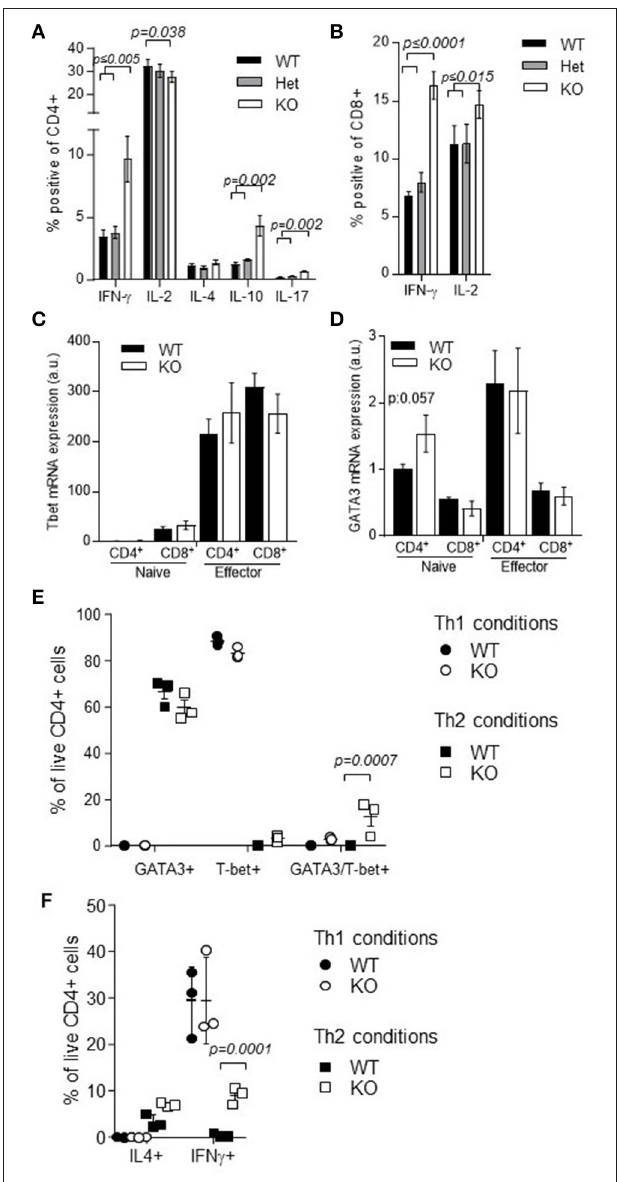
FIGURE 6 | Nup210 KO mice exhibit an inflammatory T cell signature. Splenocytes from wildtype, Nup210 het , Nup210 KO mice ( n = 6, 7, 5) were assessed by flow cytometry. (A) Cytokine production by CD4 + cells or (B) CD8 + cells after PMA/ionomycin stimulation. (C) Naïve and effector CD4 and CD8T cells were sorted from wildtype mice and Tbet and (D) GATA3 mRNA was assessed by qPCR. (E) Naïve CD4T cells were purified from wildtype and Nup210KO mice and incubated in vitro under Th1- or Th2- polarizing conditions. The proportion of cells expressing GATA3, Tbet or both GATA3 and Tbet was assessed by flow cytometry on day 3, and (F) on day 6, the proportion of cells expressing IL-4 and IFNg was likewise assessed. Statistical significance was determined using a Mann–Whitney rank test; exact p -values are shown for significant